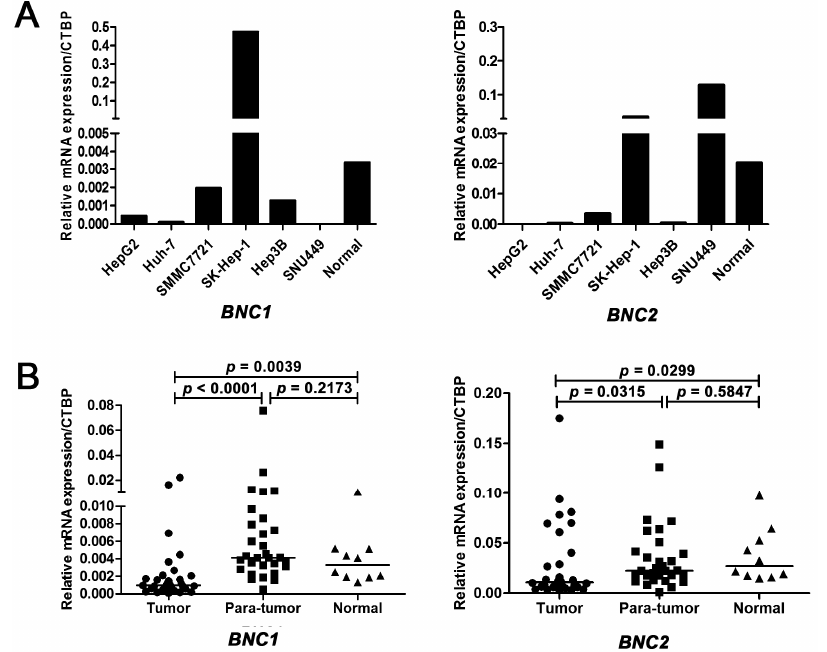
Figure 1. The mRNA expression levels of Basonuclin ( BNC ) genes in liver cancer cell lines and primary hepatocellular carcinoma (HCC) tissues detected by real-time RT-qPCR. ( A ) Expression of Basonuclin 1 ( BNC1 ) and Basonuclin 2 ( BNC2 ) in liver cancer cell lines; ( B ) Expression of BNC1 and BNC2 in 30 pairs of HCC tumor tissues and adjacent non-tumor tissues and 10 normal liver tissues. CTBP1: C-terminal binding protein 1.